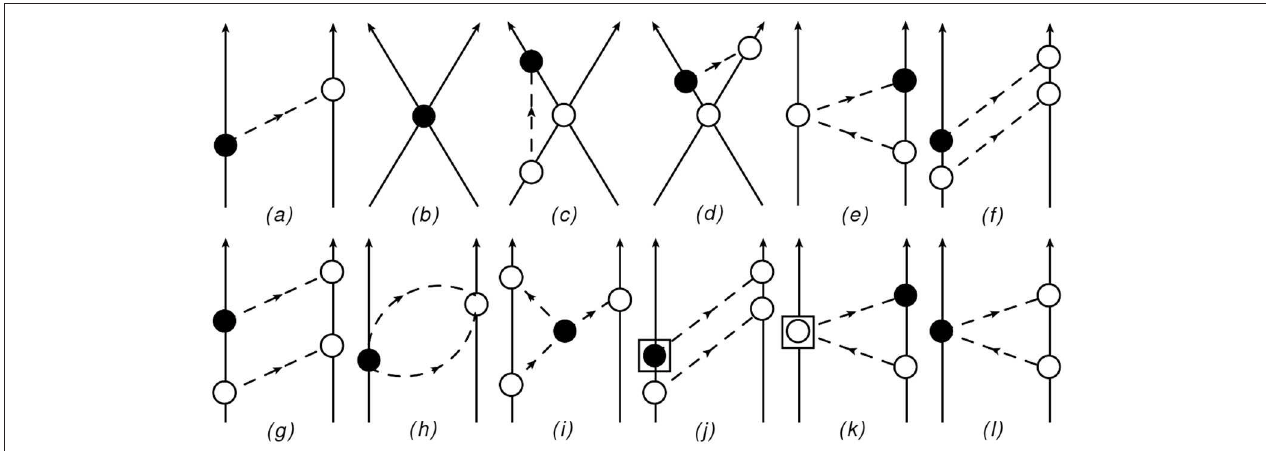
FIGURE 1 | TOPT diagrams contributing up to N 2 LO to the PVTC amplitude. Nucleons and pions are denoted by solid and dashed lines, respectively. The open (solid) circles represent LO PCTC (PVTC) vertices. The vertex depicted by a square sourrounding a solid circle denotes the contribution of the subleading PVTC π NN terms coming from the Lagrangian given in Equation (19). The vertex depicted by a square surrounding an open circle denotes the contribution of the subleading PCTC ππ NN (PVTC π NN ) terms coming from the Lagrangian given in Equation